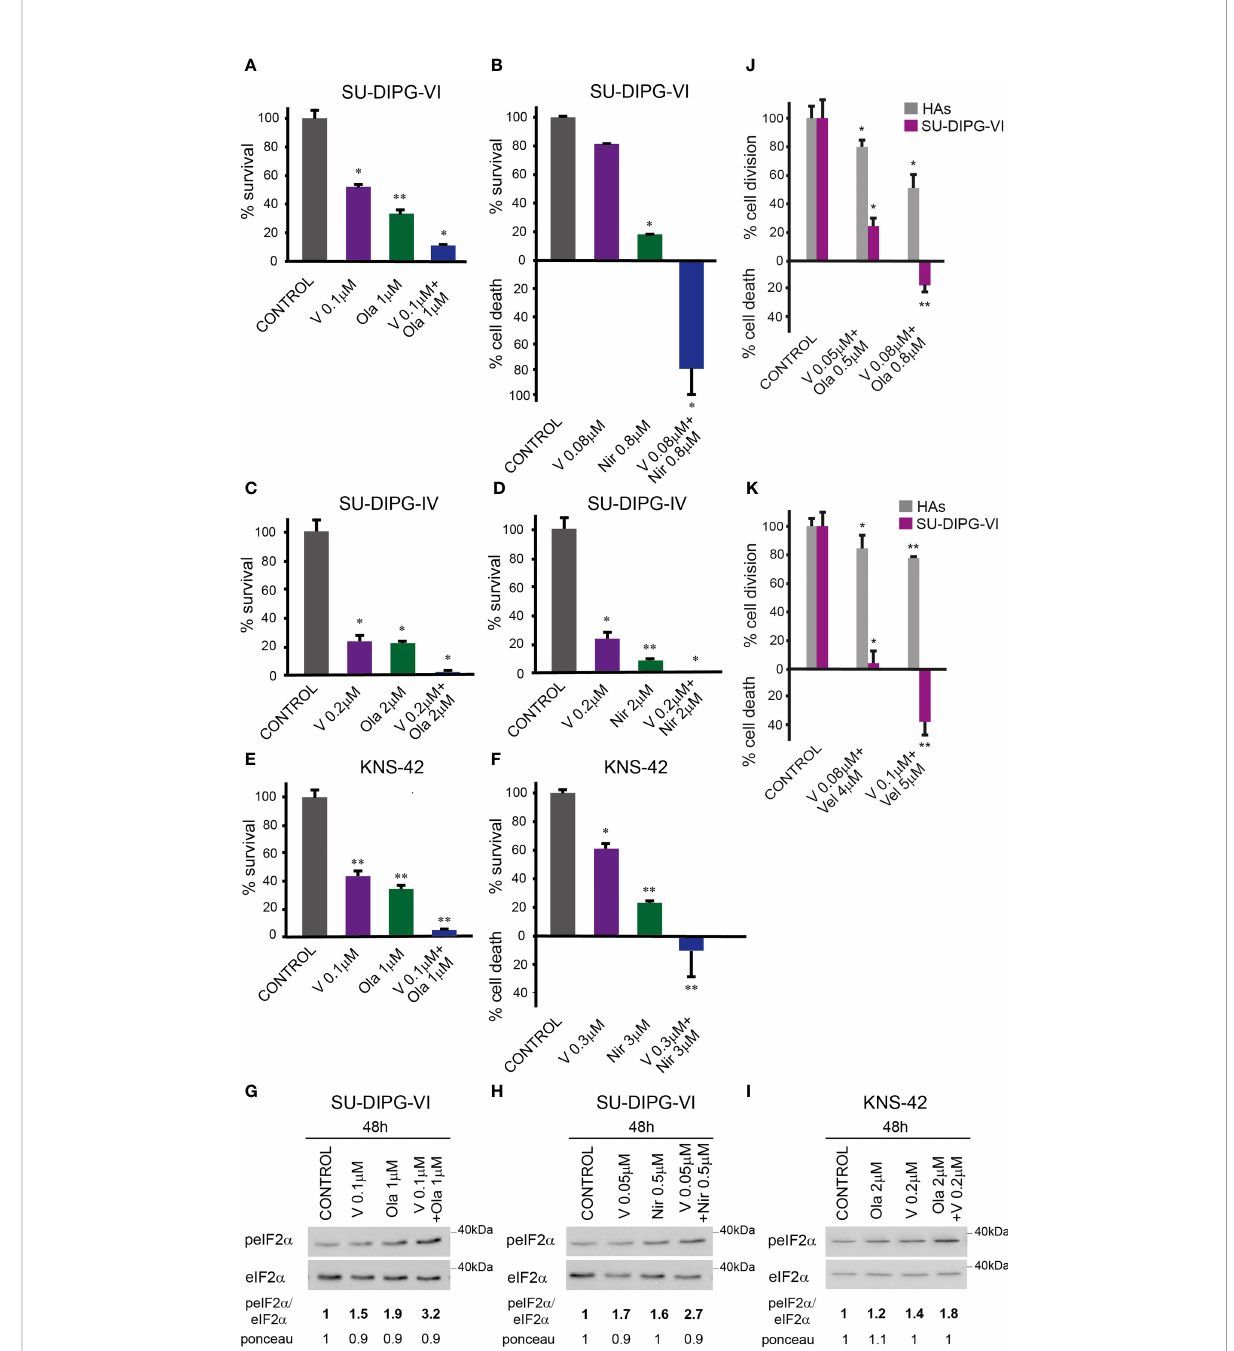
FIGURE 1 Combined treatment of vorinostat and PARPis enhanced the decrease in PED-GBM survival: SU-DIPG-VI cells (A, B) and SU-DIPG-IV cells (C, D) were plated in triplicates at a density of 11,550 or 3,300 cells/cm 2 , respectively. Drugs were added 24 h post-plating. KNS-42 were plated either for clonogenic assay (E) or for survival assay (F) at a density of 55 or 6,600 cells/cm 2 , respectively. Values are mean survival (%) ± S.D relative to control. Differences among all experimental groups, as well as between each experimental group and control, were signi fi cant - *p< 0.5, **p< 0.005. (G – I) . Cells were processed for Western blot analysis of treatment-induced changes in the ratio of peIF2 a /eIF2 a . Numbers at the bottom of the autoradiograms indicate changes of peIF2 a /eIF2 a and differences in loaded proteins (Ponceau) relative to control. (J, K) . SU-DIPG VI and HAs cells were plated in triplicates at the same density (3,300 cells/cm 2 ) and treated with drugs 24 h post-plating. Values are the mean number of cell division or cell death (%) ± S.D relative to control. Differences between treated and untreated experimental groups, as well as between SU-DIPG-VI and HAs, were signi fi cant *p< 0.05, **p< 0.005. V — vorinostat, Ola — Olaparib, Vel — veliparib, Nir — niraparib. The experiments were reproduced at least twice with similar